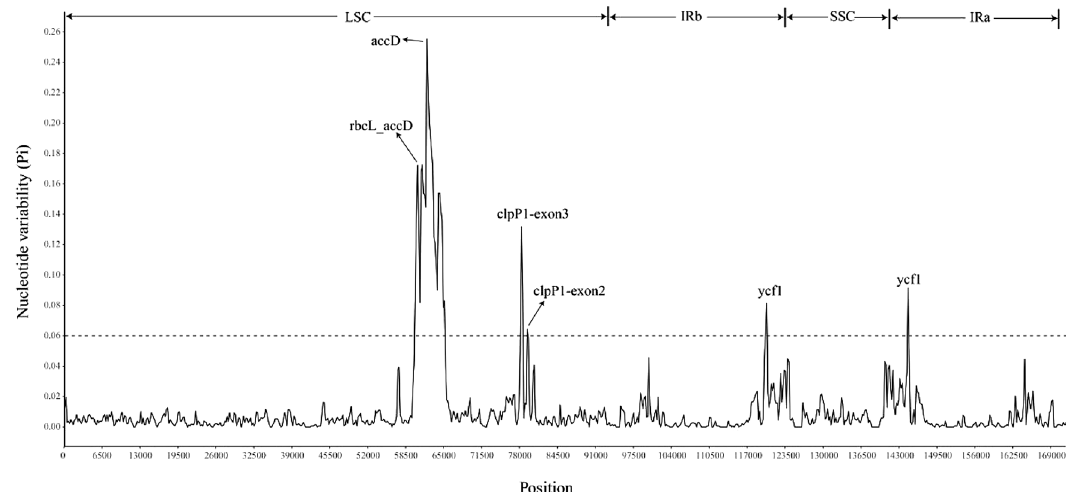
Figure 7. Nucleotide diversity of the ten Ligustrum species chloroplast genomes.